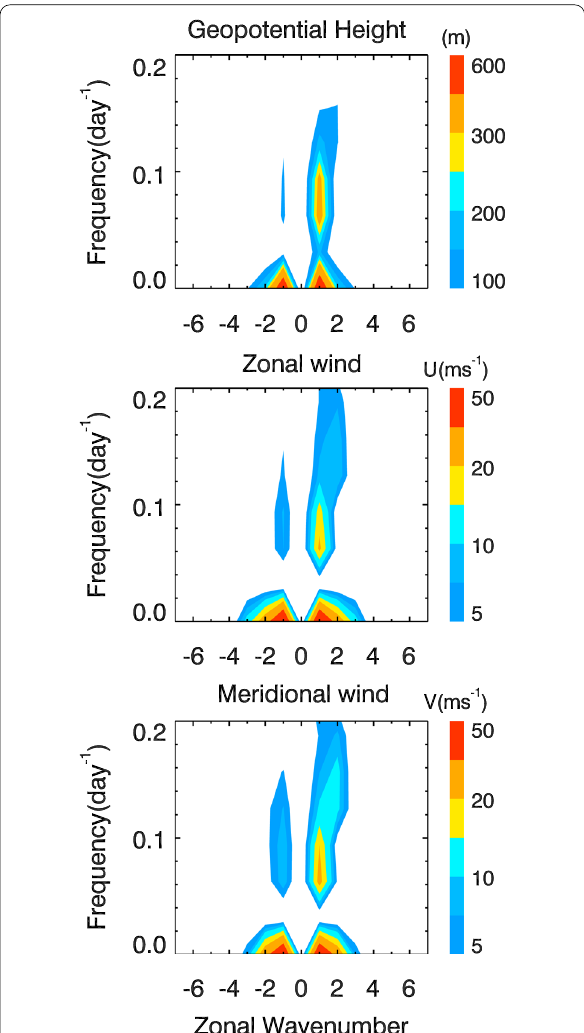
Fig. 7 Frequency–wavenumber spectra of geopotential height (top), zonal wind (middle) and meridional wind (bottom) at 1 hPa and 80